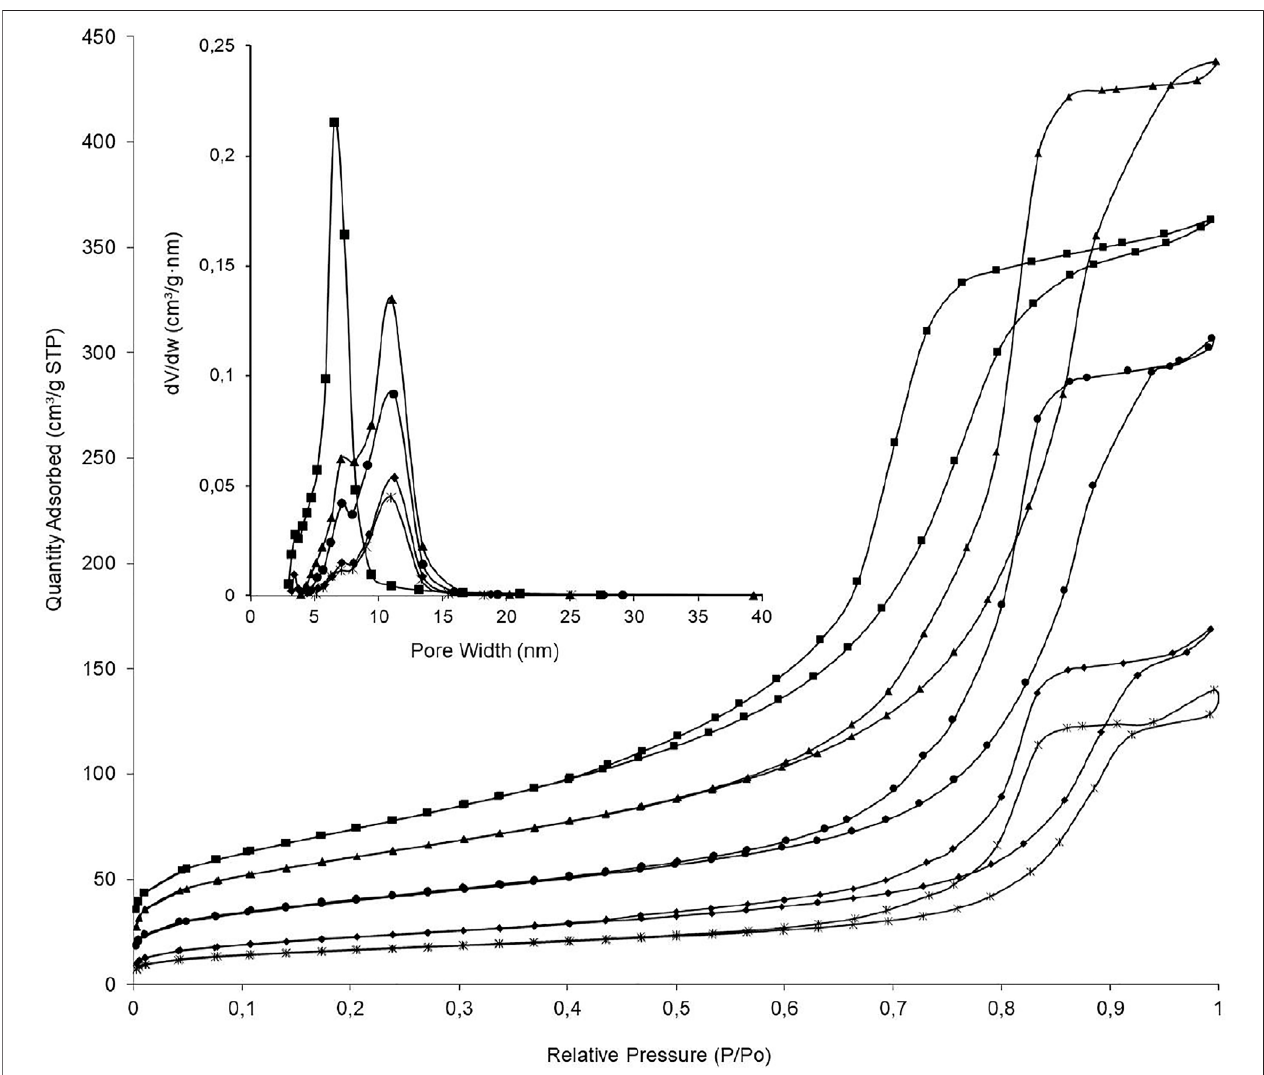
FIGURE 3 | Adsorption/desorption isotherms of N 2 at 77 K and pore size distribution of the supports and the Al 2 O 3 -MgO supported NiMo mixed phosphidic- (cid:129) sulphidic phase. ( ■ ) Al 2 O 3 , ( ▲ ) Al 2 O 3 -MgO, ( ) NiP-S/ γ -Al 2 O 3 -MgO, ( ◆ ) MoP-S/ γ -Al 2 O 3 -MgO, and ( h ) NiMoP-S/ γ -Al 2 O 3 -MgO.